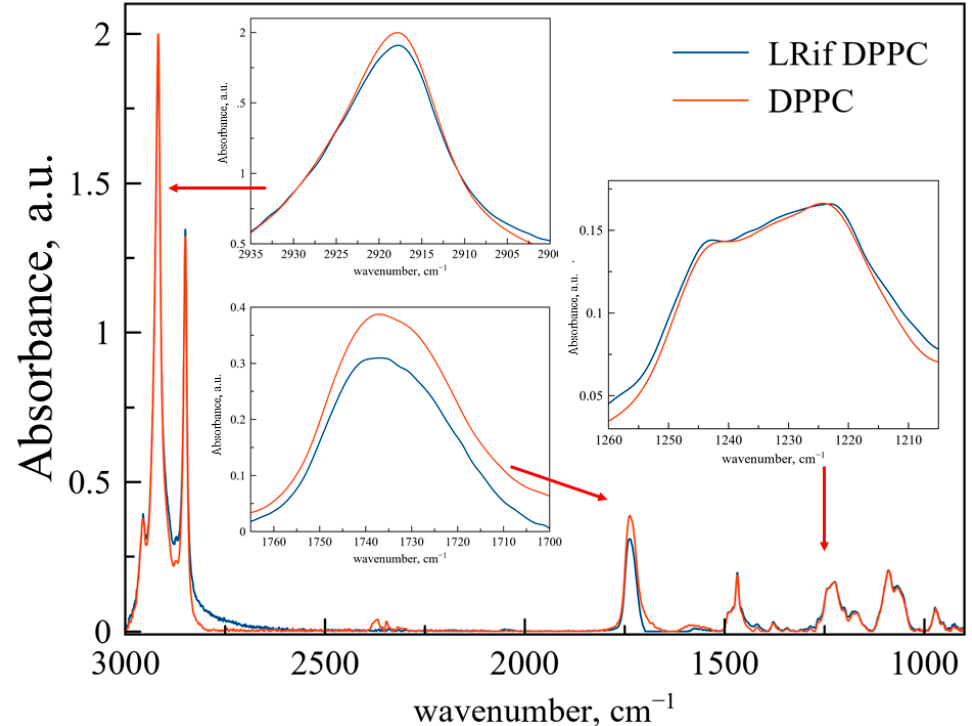
Figure 2. Normalized ATR-FTIR spectra of DPPC liposomes and LRif. Total lipid concentration 5 mg/mL, 0.02 M sodium phosphate buffer solution pH 7.4, 22 ° C. Rif spectra were subtracted as a background. Spectra of empty liposomes are red, spectra of LRif are blue. In the insets, areas of ν as (CH 2 ) , ν (CO) , ν as (PO 2 − ) are presented. Table 2. Position of the main absorption bands in the ATR-FTIR spectra of liposomes of various